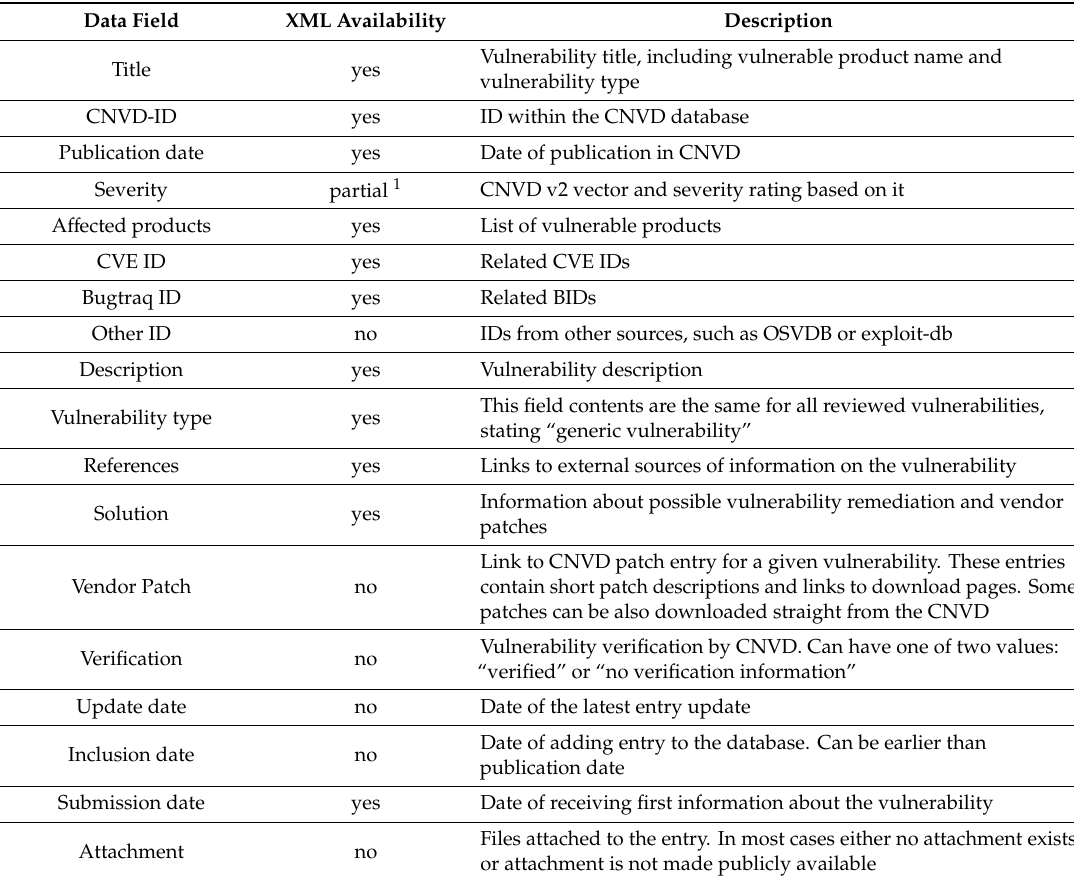
Table 4. Characterization of the data fields available in the CNVD entries found on the website and in the XML